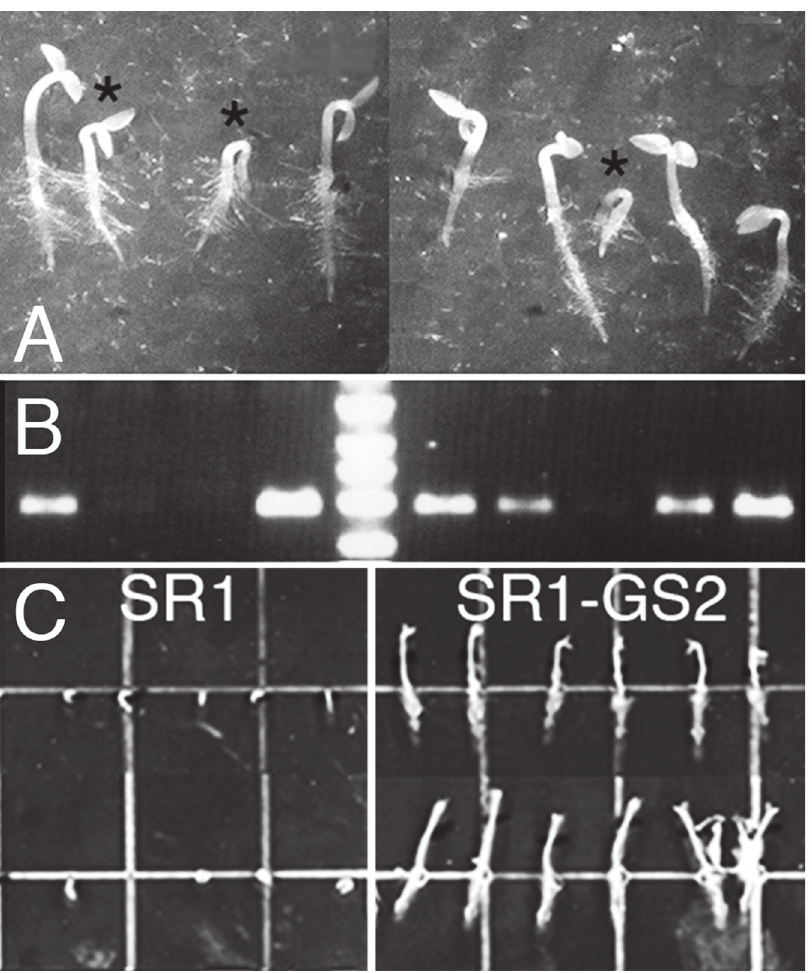
Fig 2. Tobacco seedling responses to a high temperature challenge. (A) Photograph of segregating SR1-GS24 F2 tobacco seedlings that had been heat treated for 5 min at 50°C and returned to the dark at 22°C for 16 hours. The seedlings with the asterisk above them were negative when analyzed for AtHSP101 by PCR. (B) PCR analysis of the segregating SR1-GS24 F2 tobacco seedlings shown in (A) using P-AGS- > HS101-5 ’ < - primers. (C) Photograph of the characterization of tobacco heat tolerance using the hypocotyl elongation assay on SR1 (AtHSP101 minus) and SR1-GS2 (AtHSP101 plus) seedlings following a 5 min 50°C heat challenge and 16 h recovery. These assays were used to check for line homogeneity. quality. As indicated, F2 plants of null lines 39, 52 and the Phytogen 72 check did not contain the AtHSP101 , while transgenic line 40 exhibited the HSP101 . All lines used in this study were